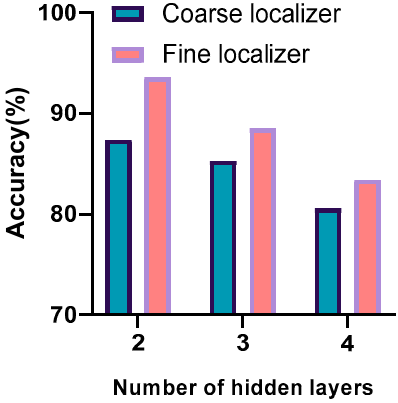
Figure 14. Positioning performance with different numbers of hidden layers.